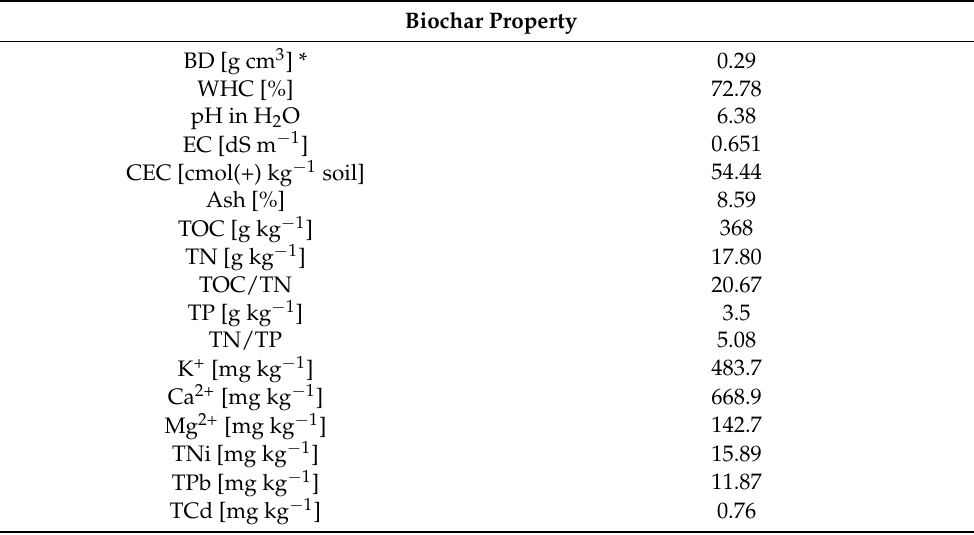
Table 2. Selected physiochemical characteristics of the studied corncob